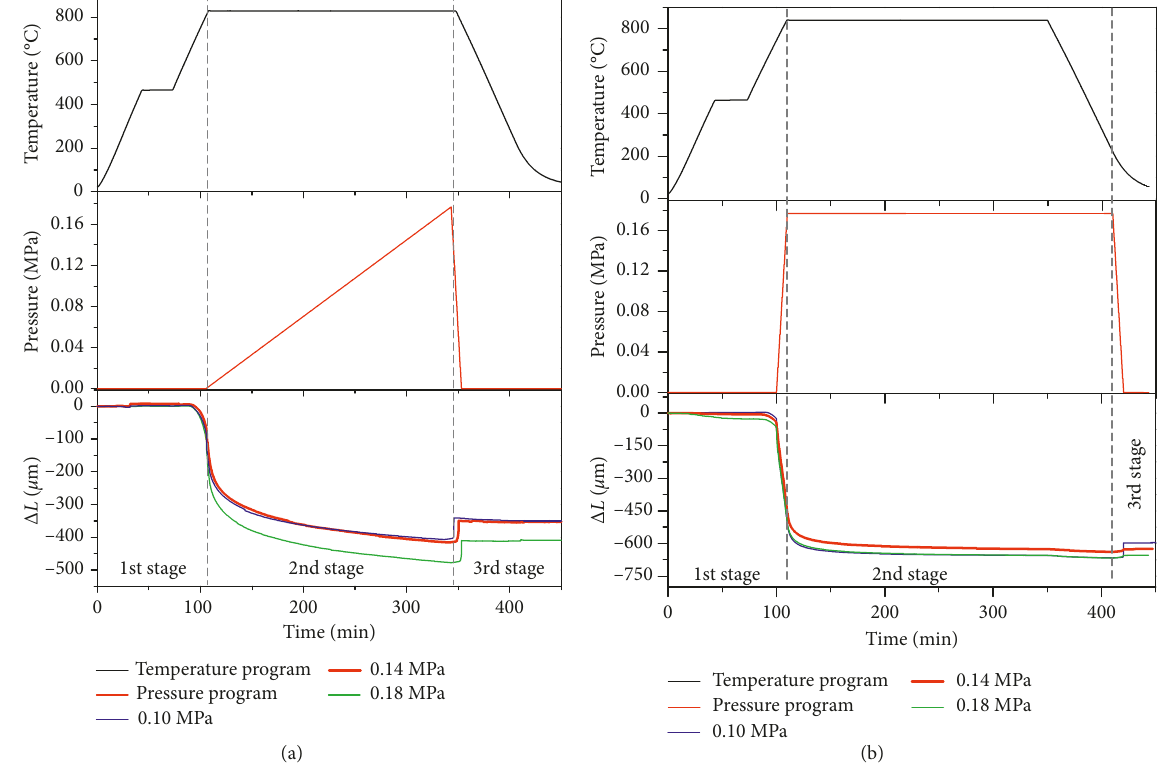
Figure 2: Height changes of the samples during the hot-pressing procedure using three different pressure factors. The solid black line represents the heating program. In the first stage, the sample is heated up to 840 ° C; in the second stage, the sample is maintained under 840 ° C for 4h; and in the third stage, the sample is cooled down to room temperature. (a) BGO I, (b) BGO II.